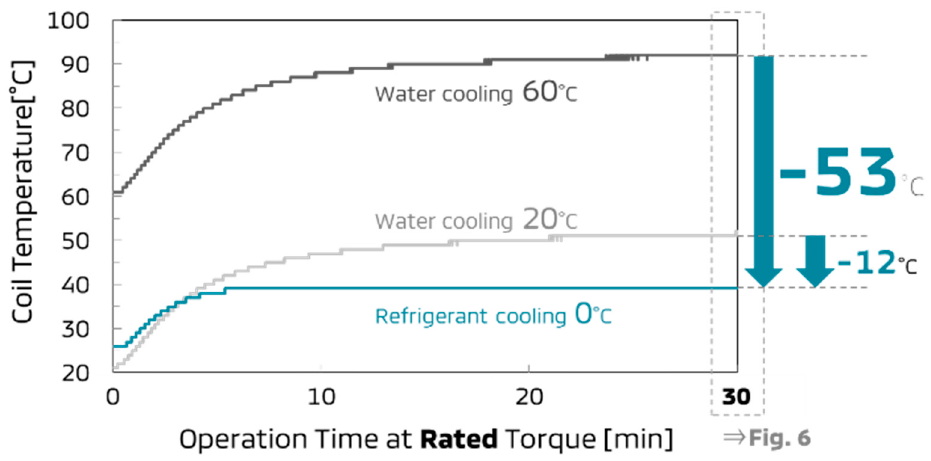
Figure 5. Operation time at rated torque vs coil temperature.